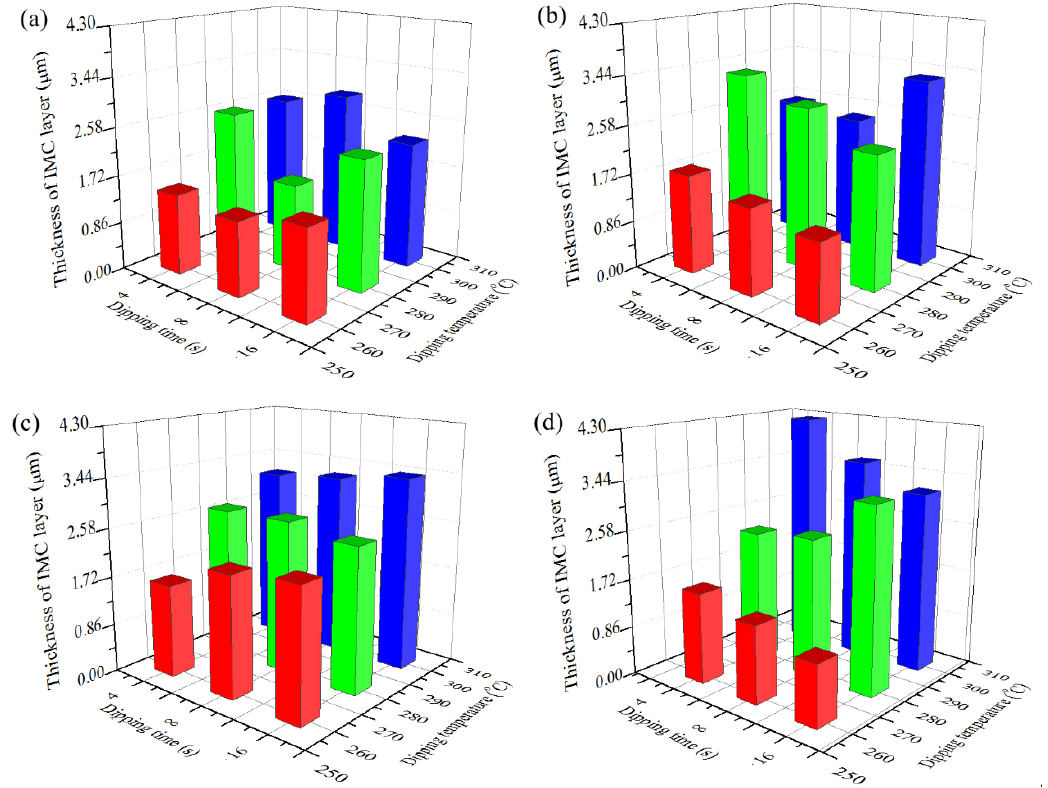
Figure 5. Variation of IMC layer thickness with dipping temperature and dipping time for different types of copper foils: ( a ) C70250 foils, ( b ) C19400 foils, ( c ) C19210 foils, and ( d ) C11000 foils.